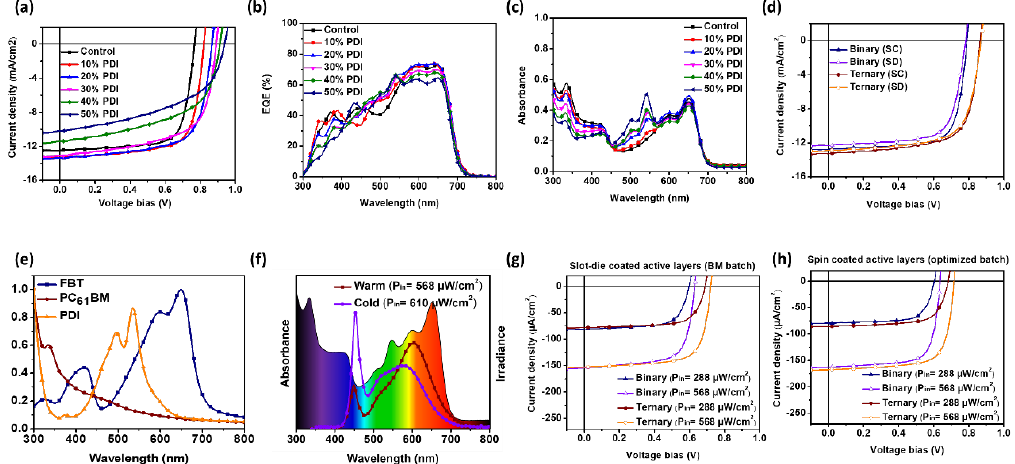
Figure 13. ( a ) Device J – V curves of OPV devices with spin-coated active layers containing different PDI% in the ternary system under 1 sun illumination; ( b , c ) are the corresponding device EQE and UV–Vis optical absorption spectra, respectively. The control device corresponds to the binary FBT: PC 61 BM system, ( d ) device J – V curves of OPV devices, spin-coated vs. slot-die, with binary and ternary active layers under 1 sun illumination, ( e ) optical absorption spectra of the neat films spin coated from o -xylene (10 mg/mL), ( f ) emission spectra of a 2700 K (warm) and 6500 K (cold) at 2000 lux LED illumination, with the optical absorption spectrum of the spin-coated ternary blend [FBT: PC 61 BM: PDI (1:1.2:0.3)] from a 20 mg/mL in o -xylene solution (containing 1% ( v / v ) p-anisaldehyde, AA) superimposed to show the match between the emission spectra of the LEDs and the absorption spectrum of the ternary blend, ( g ) device J – V curves of OPV devices slot-die-coated with binary and ternary (20 wt.% PDI) active layers under different indoor light illuminations, and ( h ) device J – V curves of OPV devices with spin-coated binary and ternary (20 wt.% PDI) active layers under different warm indoor light illuminations. ZnO/PEIE was used as the ETL [104]. ( a – h ) Reproduced with permission from [104]. Copyright 2020 American Chemical